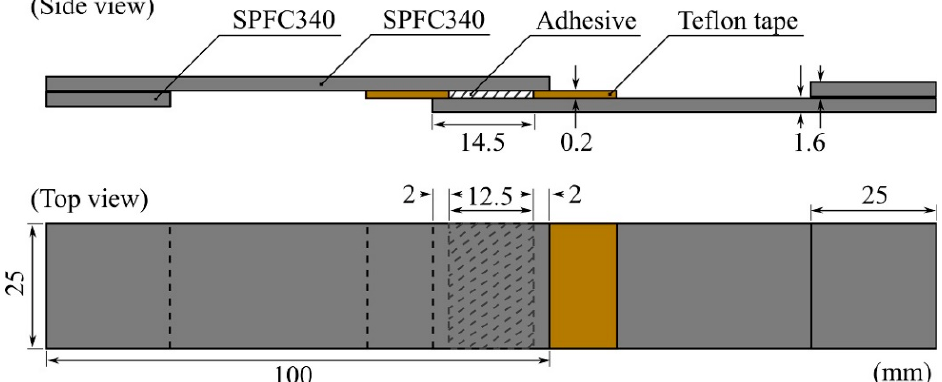
Figure 1. Schematic illustration of the specimen for the single-lap joint (SLJ) test. The Teflon tapes were attached at 14.5 mm from the end tips, and the two adherends were overlapped at an adhesive length of 12.5 mm after the adhesive application. Grip tips with lengths of 25 mm were attached to each side for